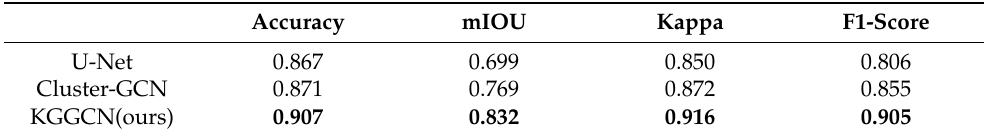
Table 1. The mIOU, Kappa, and F1-Score of the three models.